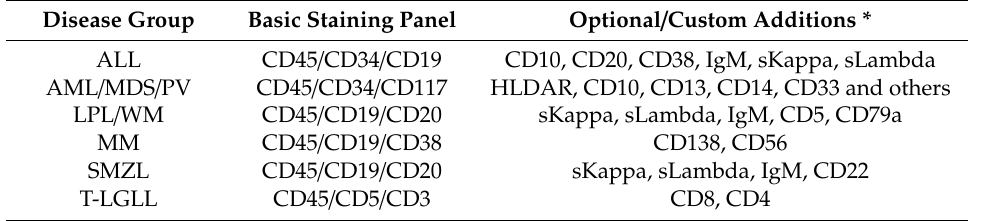
Figure A1. Laboratory Information Management. An overview of the data flow in the ProGen and ProSeq studies. Patient consent is stored in a REDCap database (DB), and clinical data of the